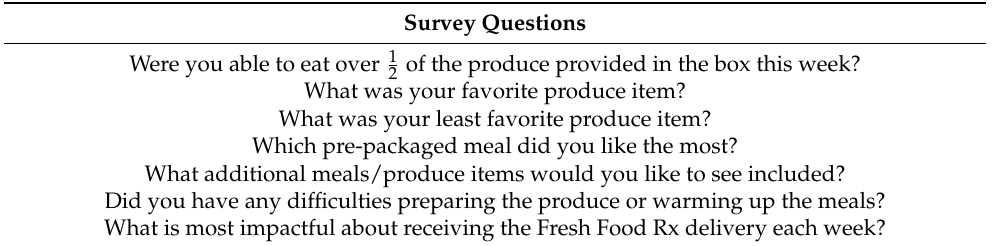
Table 3. Survey Questions Asked of Participants of the Fresh Food Rx